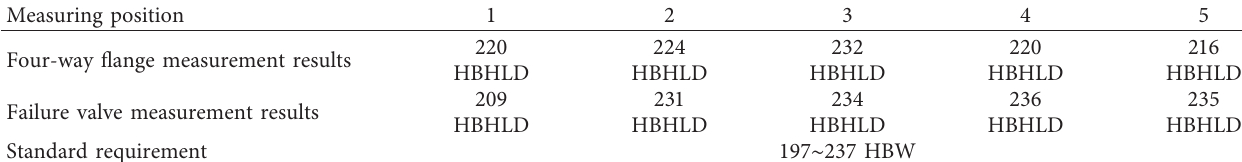
Table 3: Rockwell hardness test results.